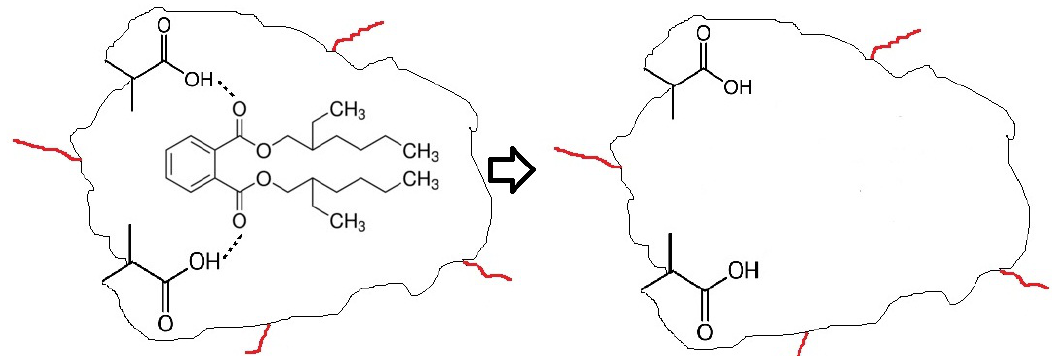
Fig. 1. Schematic representation of MIPs preparation and removing of DEHP to create Matrix